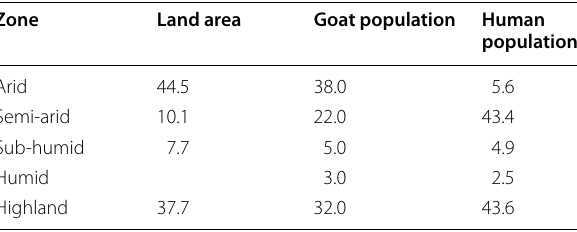
Table 1 Distribution of Ethiopian goats by agro-ecological zone (%). Source : Jankhe